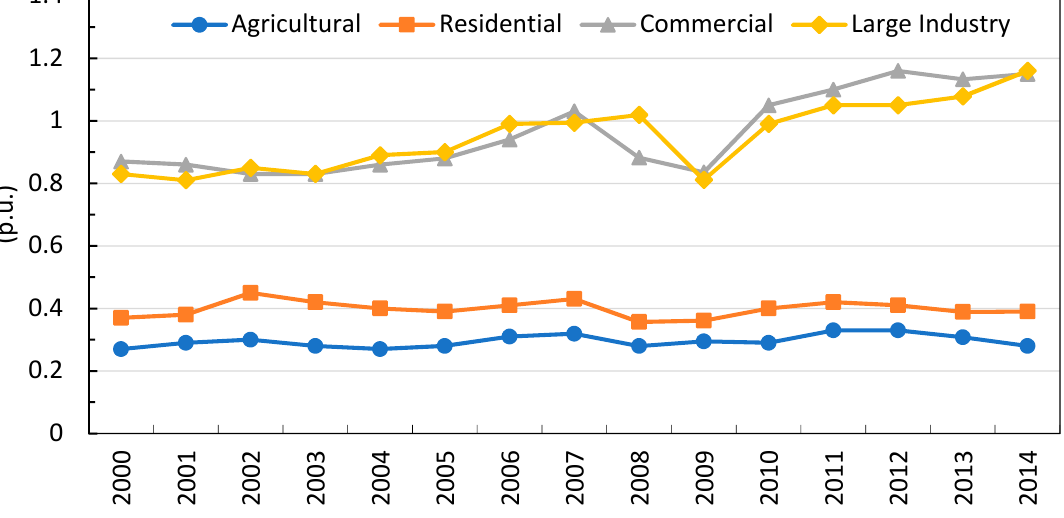
Figure 2. Price/cost ratio of representative tariffs.